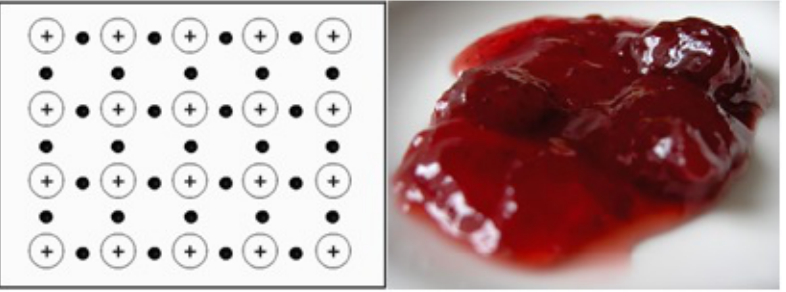
Figure 1. The uniform spread of the potential generated by the positive nuclei as a